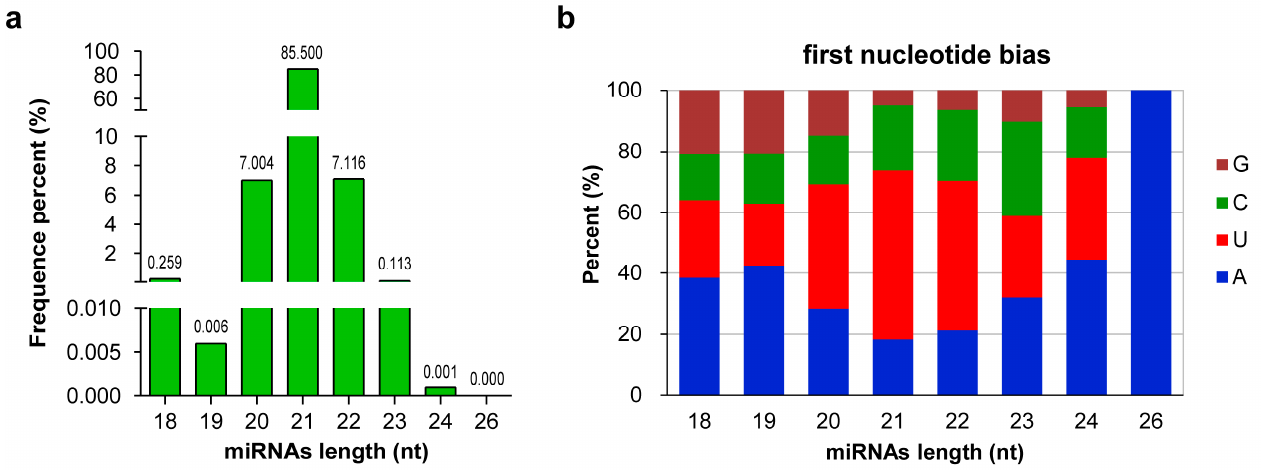
Figure 2. Sequence information of all microRNAs (miRNAs) in wintersweet floral buds. ( a ) Sequence length distribution of miRNAs. The numbers in the figure represent the percentage of miRNAs sequences with different lengths in the total miRNA sequences. ( b ) First base distribution of miRNAs of different lengths. A, U, C, and G represent adenine, uracil, cytosine, and guanine, respectively. ( a , b ) were generated with GraphPad Prism 9 software [48].